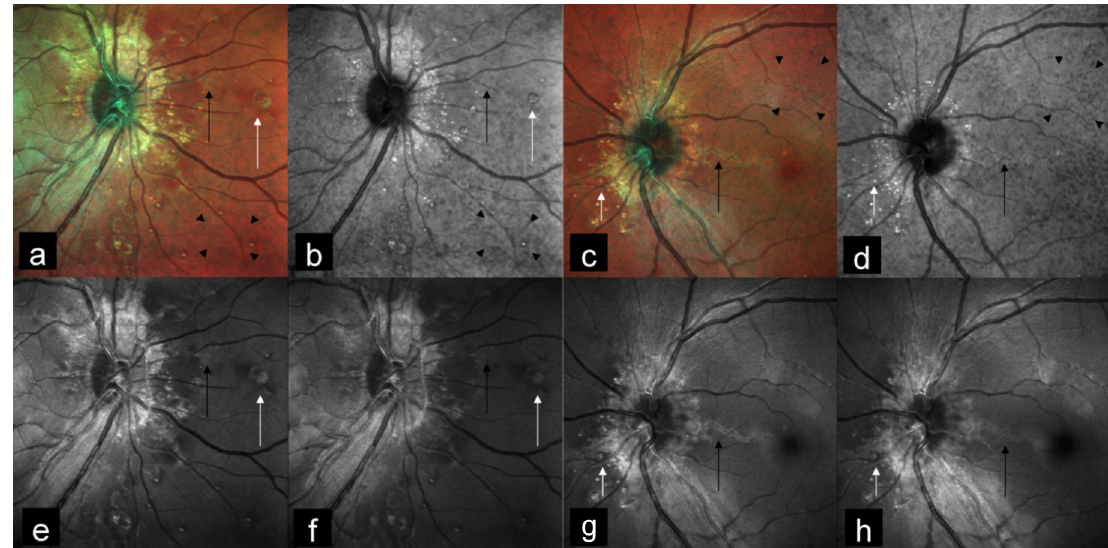
Figure 4: MC (a, c) of both eyes highlighted AS (black arrows), peau d’orange (arrow heads) and comet lesions (white arrows) clearly. AS was better visualized on IR (b, d) (black arrows). MC (a, c) highlighted peau d’orange in greenish color (arrow heads) which was seen as hyporeflective and hyperreflective patches on IR (arrow heads) (b, d). Comet lesions showed increased signal